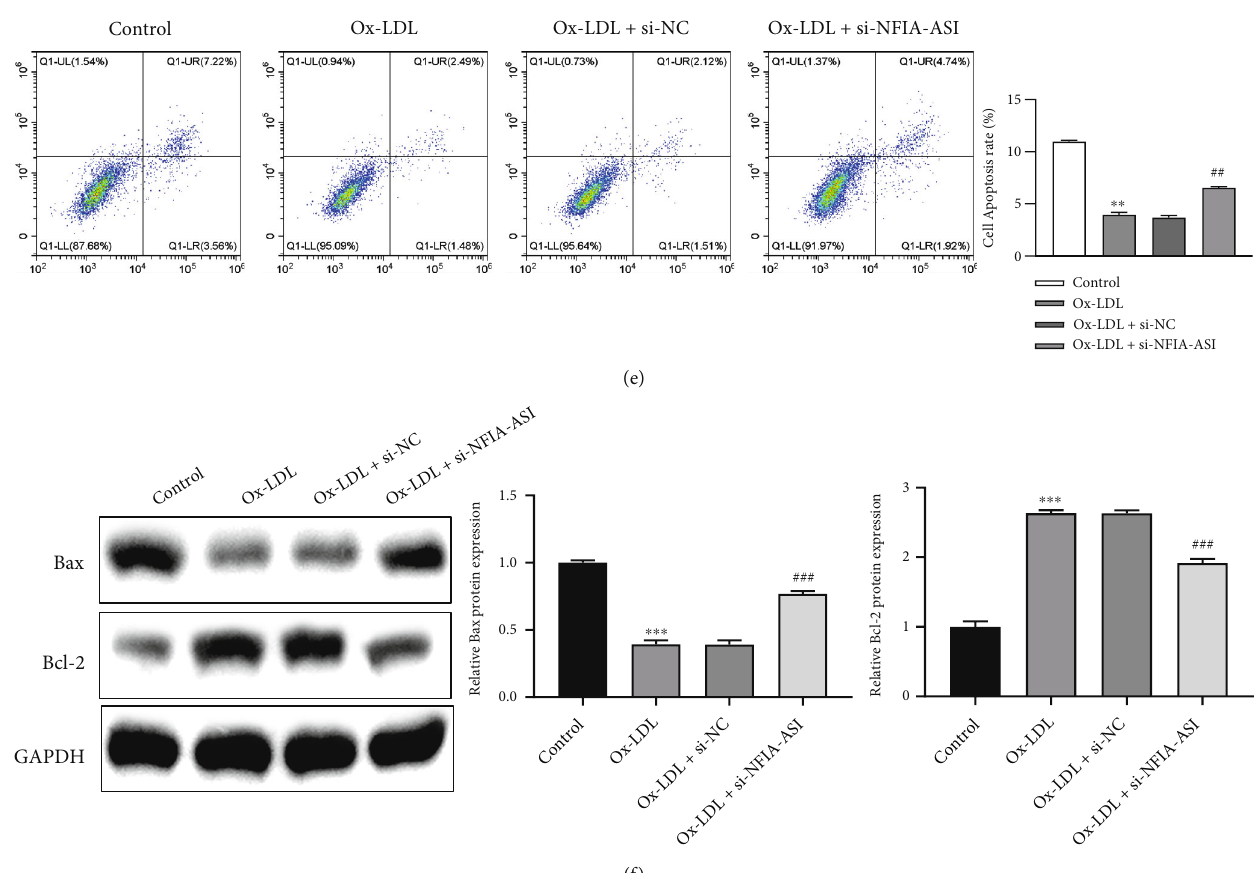
Figure 2: KD of NFIA-AS1 inhibits the proliferation, migration, and invasion of Ox-LDL-induced VSMCs and promotes apoptosis. (a) Cell viability of VSMCs in control, Ox-LDL, Ox-LDL +si-NC, and Ox-LDL +si-NFIA-AS1 groups at 0, 24, 48, and 72 hours were detected by CCK-8 assay. (b) VSMCs in these four groups were stained with EdU. The nucleus was stained with 2-(4-Amidinophenyl)-6- indolecarbamidine dihydrochloride (DAPI). The proportion of EdU-positive cells was counted. Scale bar =50 μ m. The migration (c) and invasion (d) capacity of VSMCs was assessed by Transwell assay. Scale bar =50 μ m. (e) VSMCs were stained with PI and the cell apoptosis was evaluated by fl ow cytometry. (f) The expression of apoptosis-related proteins Bax and Bcl-2 was determined by western blot. GAPDH was the internal reference. * P < 0 : 05 , ** P < 0 : 01 , and *** P < 0 : 001 versus control group. # P < 0 : 05 and ## P < 0 : 01 versus Ox- LDL +si-NC